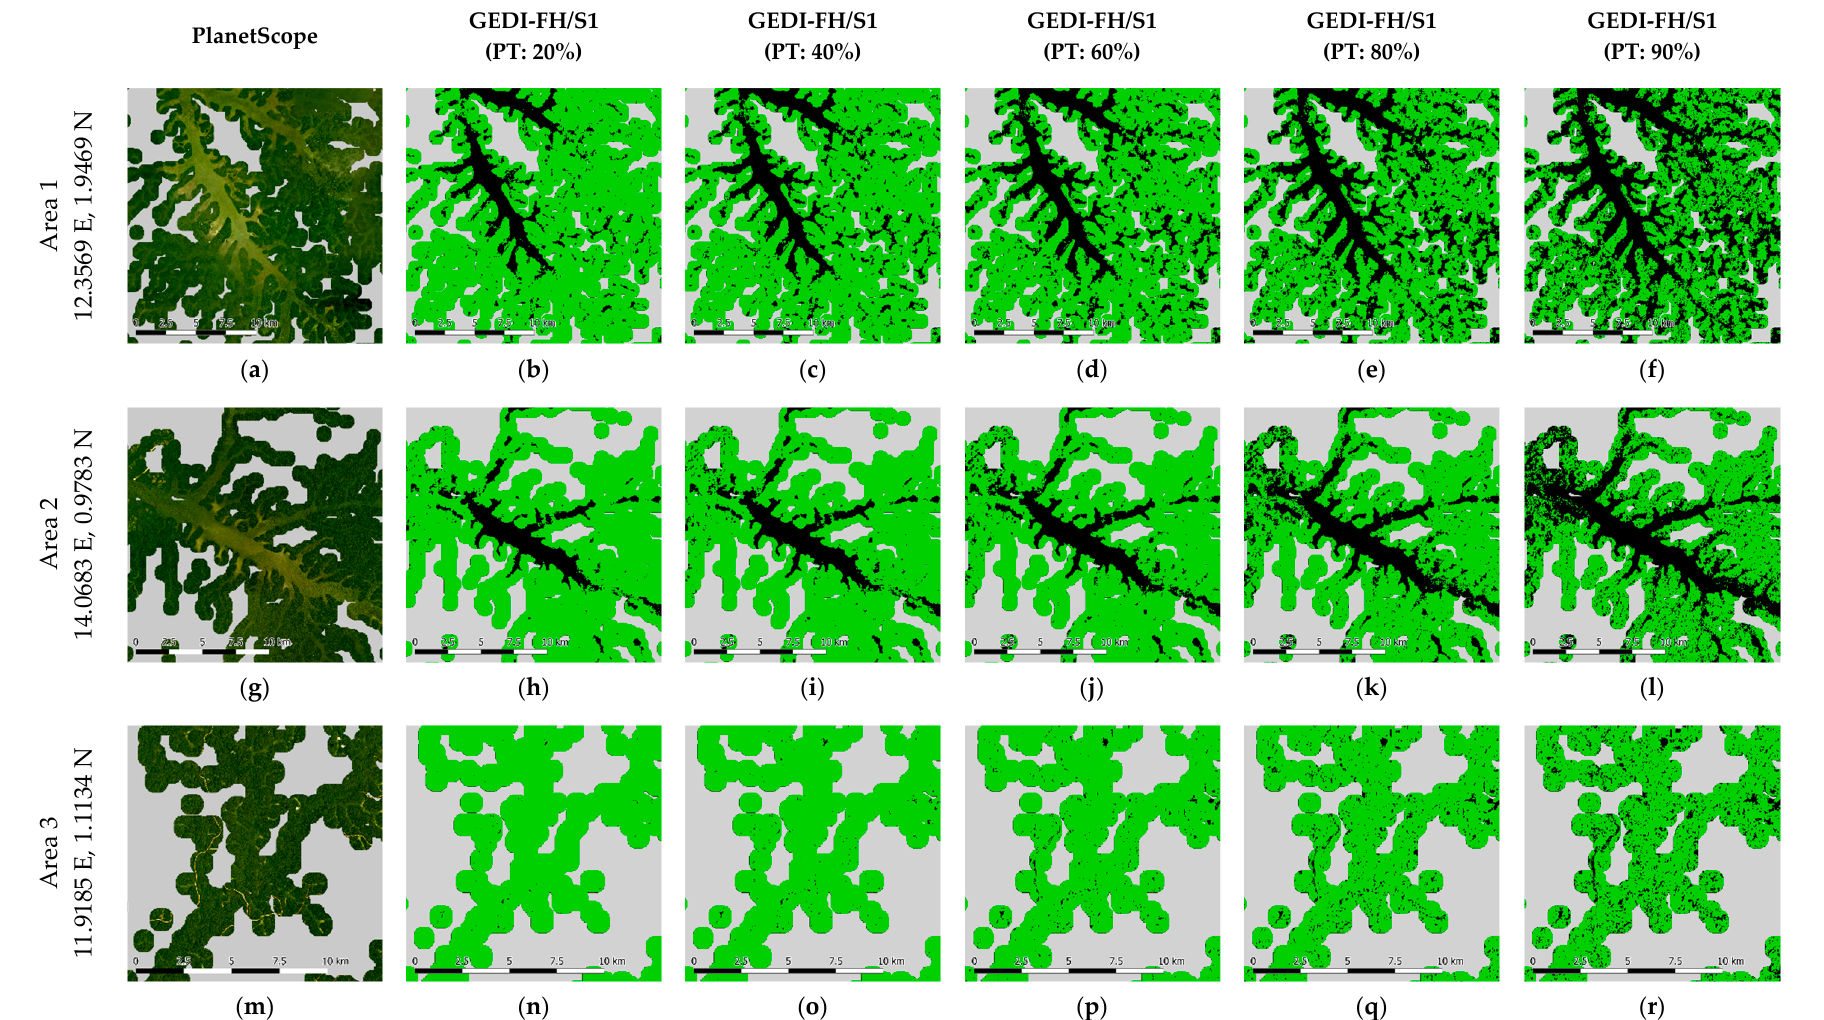
Figure 5. Detail maps comparing GEDI-FH/S1 masks with different PTs in three wetland regions in Gabon ( a – r ). PlanetScope imagery is also given for reference. Only areas within the 500 m CIFOR wetland buffer are considered as the study region; other areas are masked out in grey. Forest is shown in green and non-forest in black.